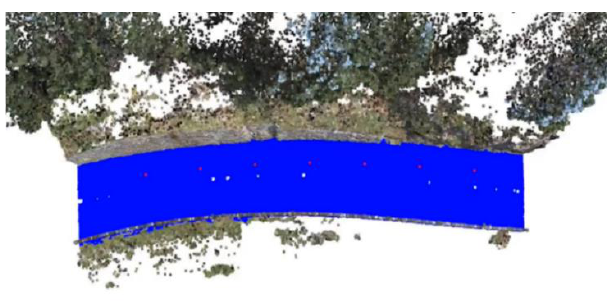
Figure 7. Roadway segmented in blue. The seeds in red are the closest points to each trajectory